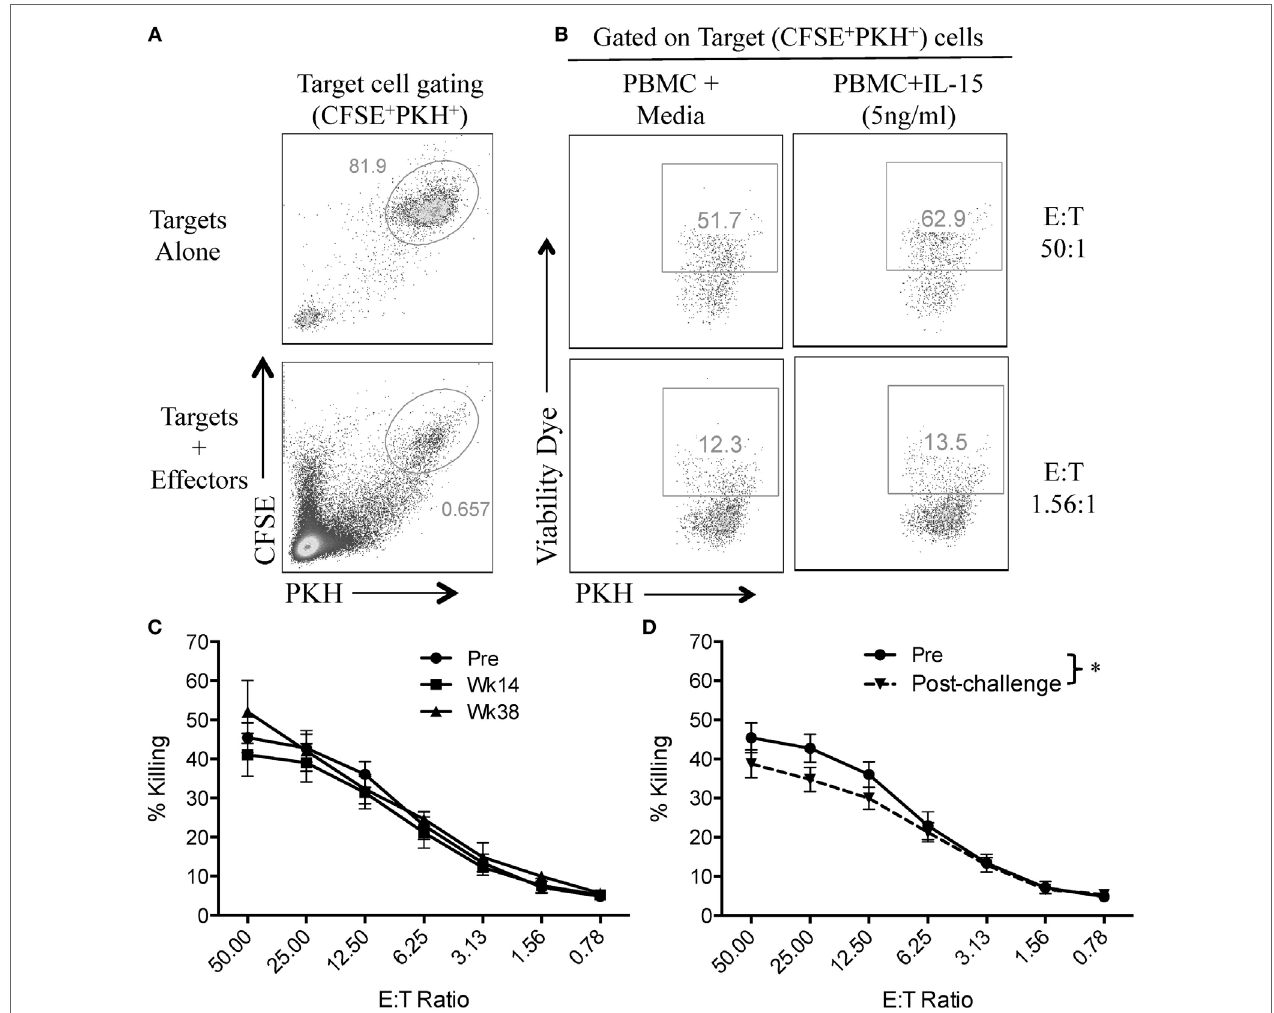
FigUre 2 | siV infection impairs natural cytotoxic capacity of rhesus macaque circulatory nK cells . Frozen PBMCs were thawed and cultured overnight in media alone or in media supplemented with 5 ng/ml of recombinant rhesus macaque IL-15. PBMCs were then co-cultured with CFSE/PKH double-labeled 721.221 target cells at different effector-to-target cell ratios for 4 h. (a) Gating strategy used to differentiate 721.221 target cells (CFSE + PKH + ) from unlabeled effector cells. (B) Killing of CFSE + PKH + target cells as measured by the incorporation of the aqua amine-reactive dye. (c,D) 721.221 target cell killing by PBMCs from vaccination (c) and post-challenge (D) time-points as compared with PBMCs obtained pre-vaccination (Pre). Effector cells used in C and D were rested overnight in media alone. Data reported are means ± SEM. * p < 0.05 indicates statistically significant differences between the indicated killing curves as determined by two-way